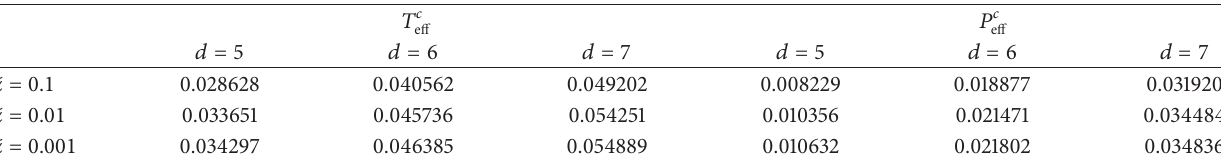
, 𝑃 𝑐 with fixed 𝑄 = 1 and spacetime dimension 𝑑 = 5, 6, 7 and GB parameter ̃𝛼 = 0.1, 0.01, 0.001 , eff eff